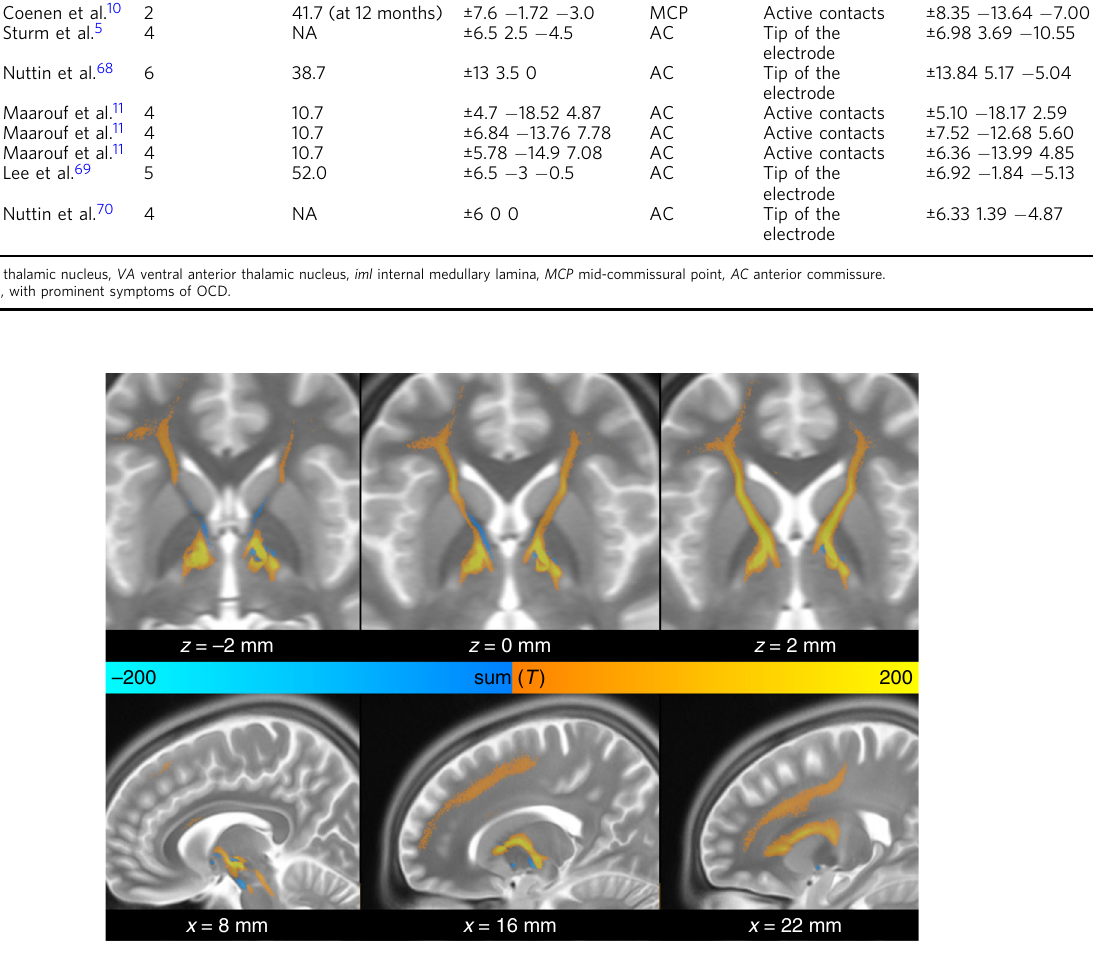
Fig. 6 Anatomical course of discriminative fi bers shown in MNI space. The tract is connected to the subthalamic nucleus and mediodorsal nucleus of the thalamus, traverses through the anterior limb of the internal capsule and has a wide array of frontal connections including dorsal anterior cingulate cortex and ventrolateral prefrontal cortex. The tract most negatively associated with clinical improvement was the anterior